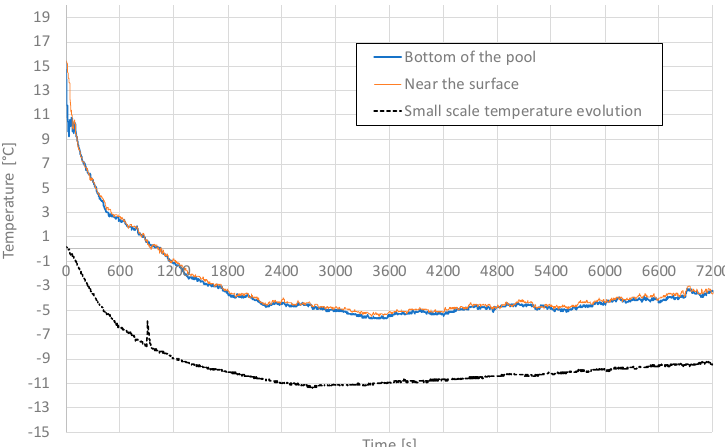
Figure 11. Temperature evolution along time for the three measured depths.